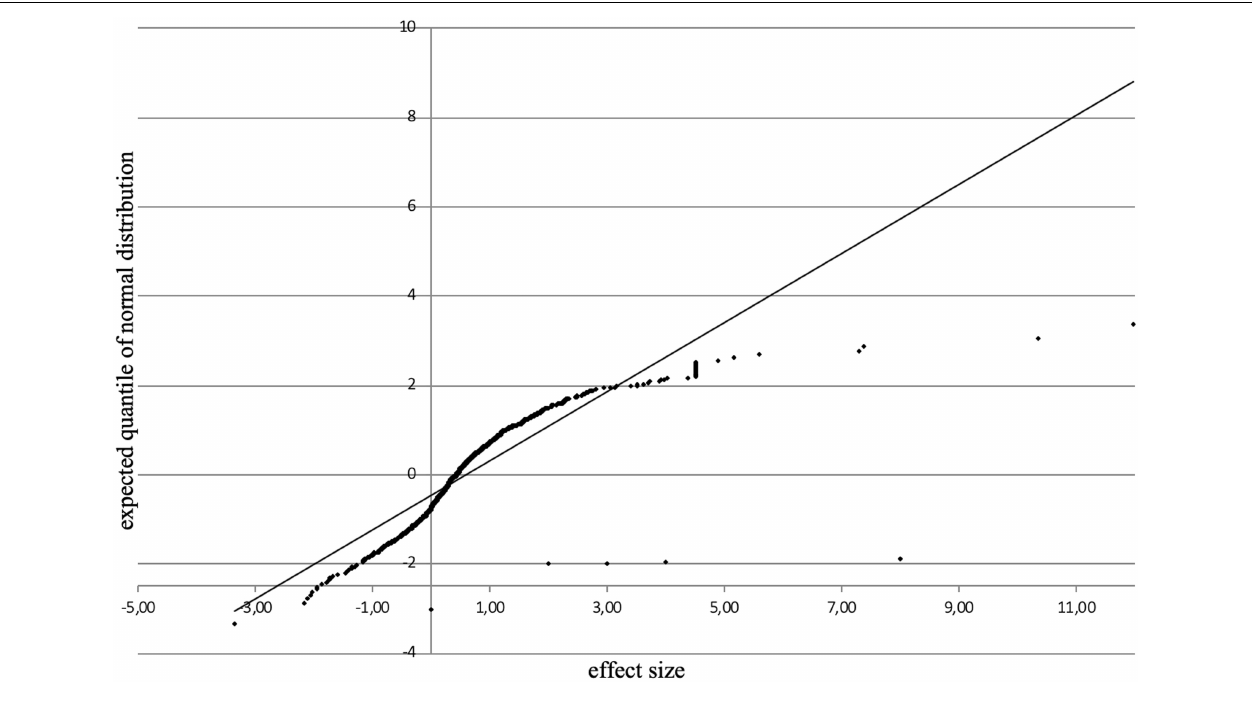
FIGURE 4 | Normal-quantile-plot of all study